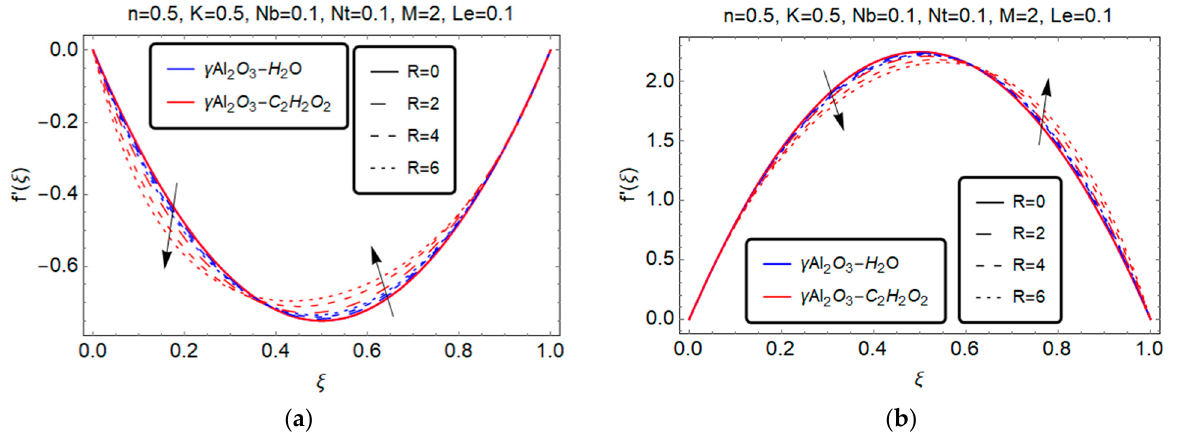
Figure 2. Effect of squeezed number 𝑅 on 𝑓′(𝜉) . ( a ) S > 0; ( b ) S < 0. Figure 3a. In the case of injection, an opposite behavior is observed.